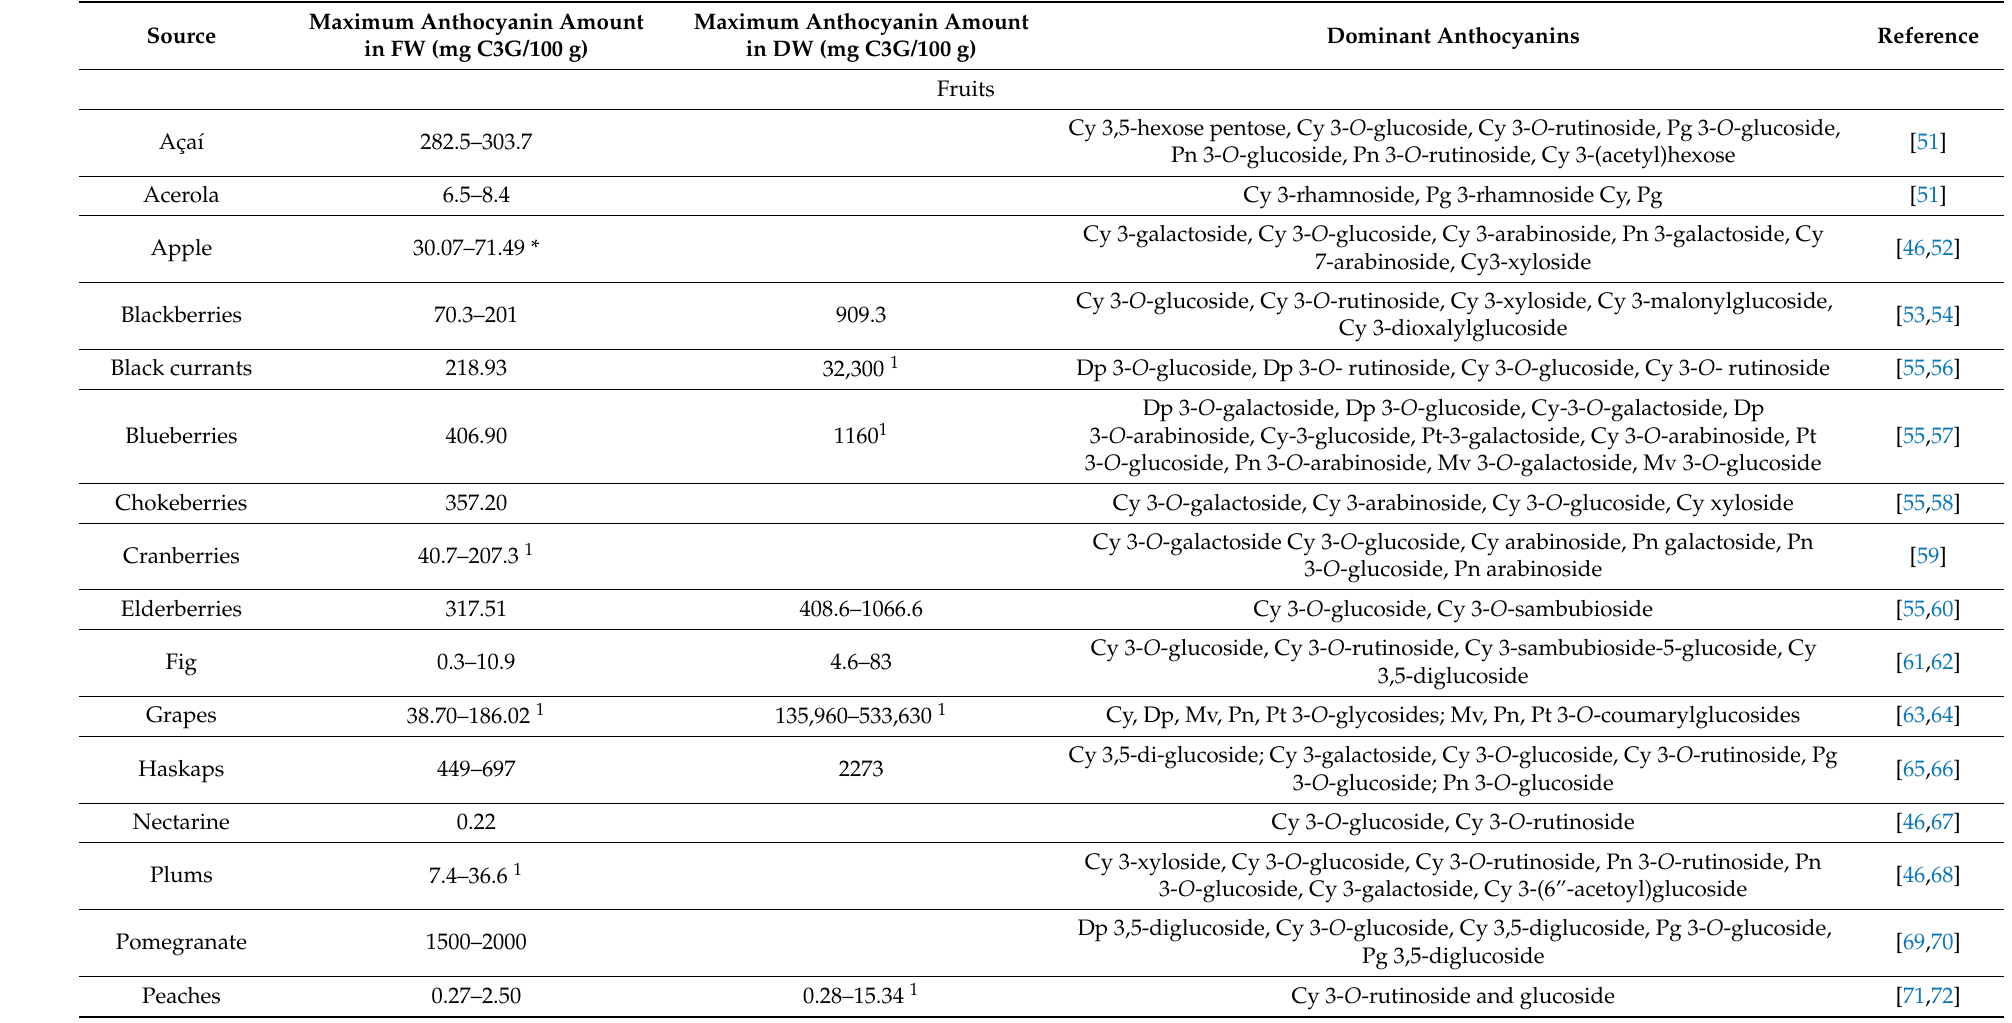
Table 1. Concentration of anthocyanins in fresh weight (FW) and dried weight (DW) in fruits, beverages, and